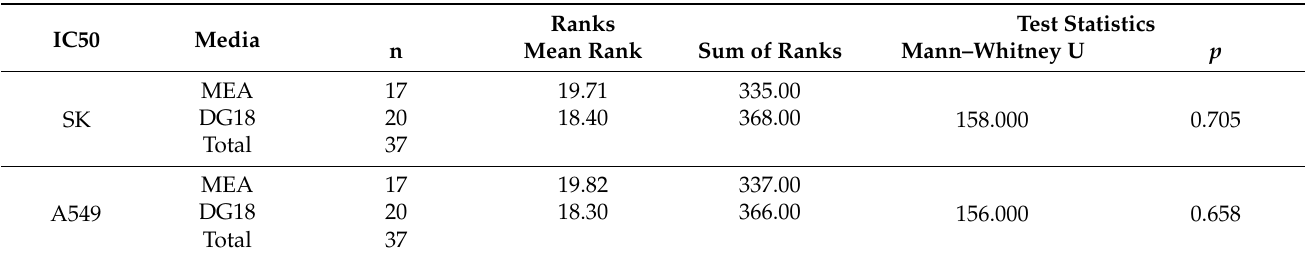
Table 6. Comparison of IC50 levels in either SK or A549 cells from isolates first isolated on MEA and DG18. Mann–Whitney test